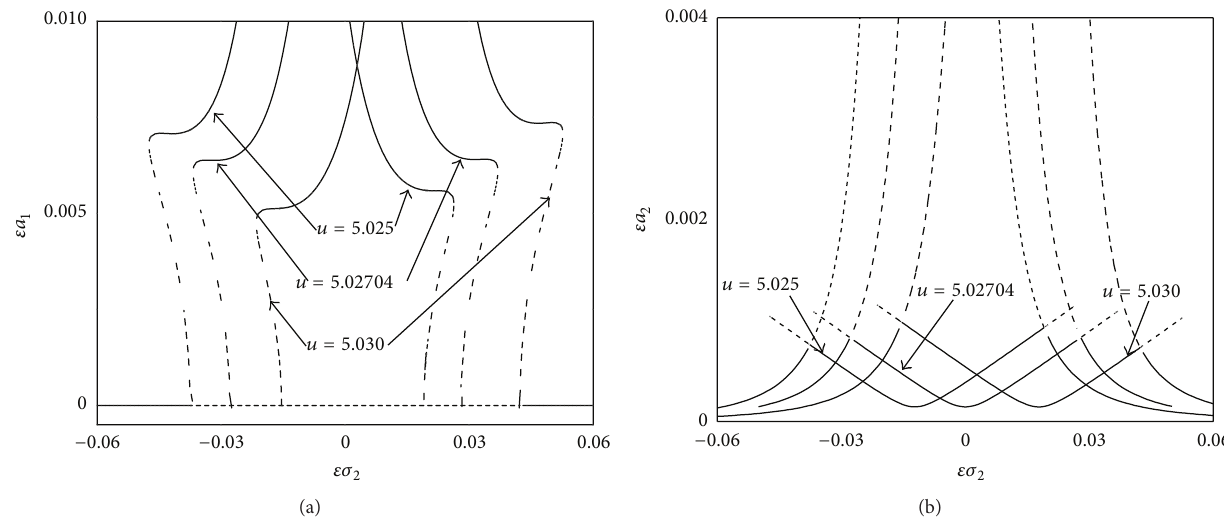
Figure 9: Amplitude-frequency curves of the second superharmonic resonance for different flow speeds: (a) the first mode and (b) the second